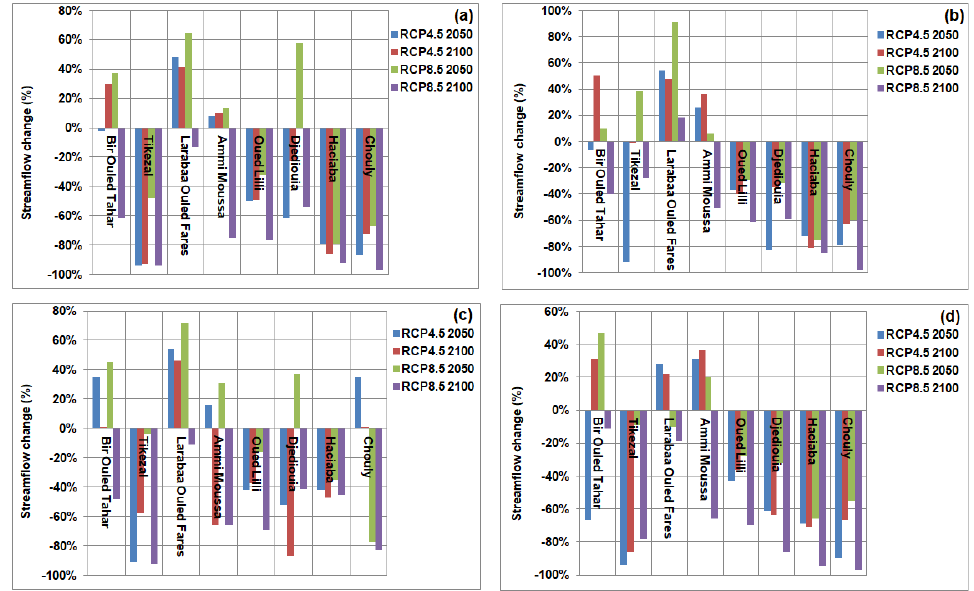
Figure 10. Changes in spring streamflow relative to the historical period under two scenarios (RCP4.5 and RCP8.5): ( a ) quantile mapping, ( b ) scaled distribution mapping, ( c ) quantile delta mapping, and ( d ) model RAW.